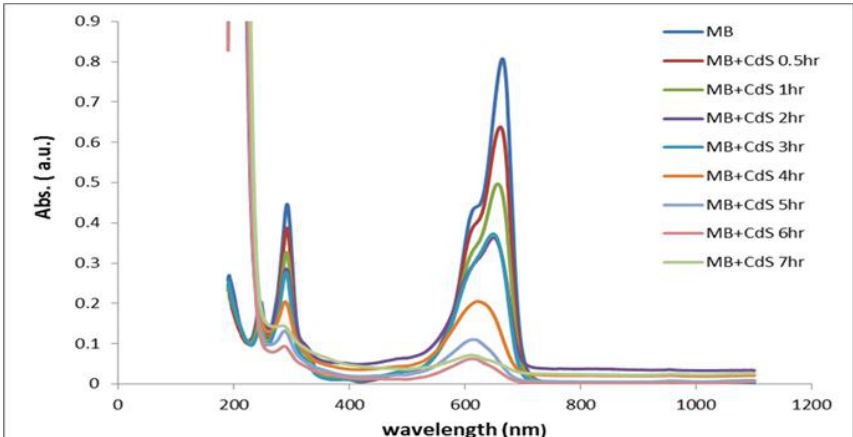
Fig.3: Absorption spectra of CdS in various times.